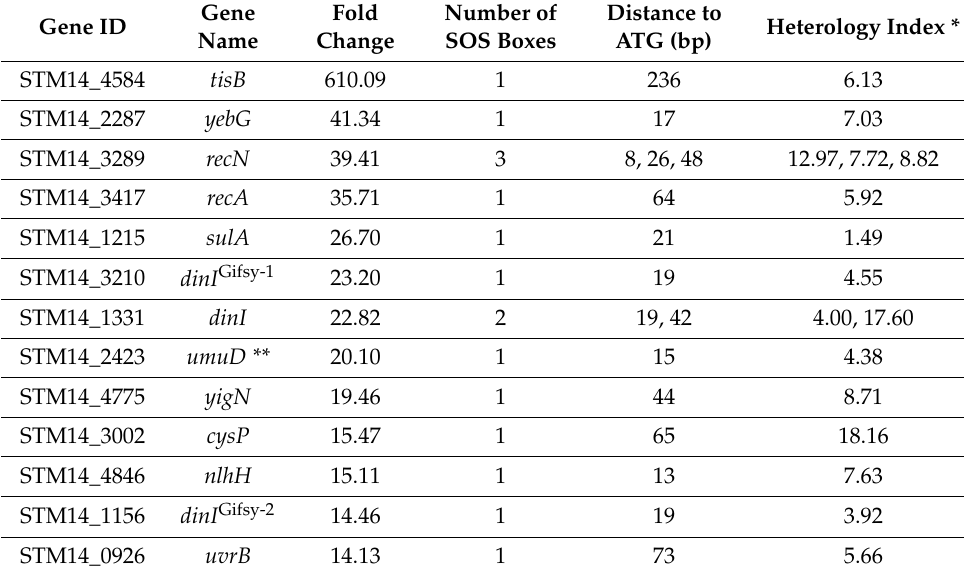
Table 1. SOS response genes of S. enterica identified as loci that harbor putative LexA boxes and are upregulated in the presence of nalidixic